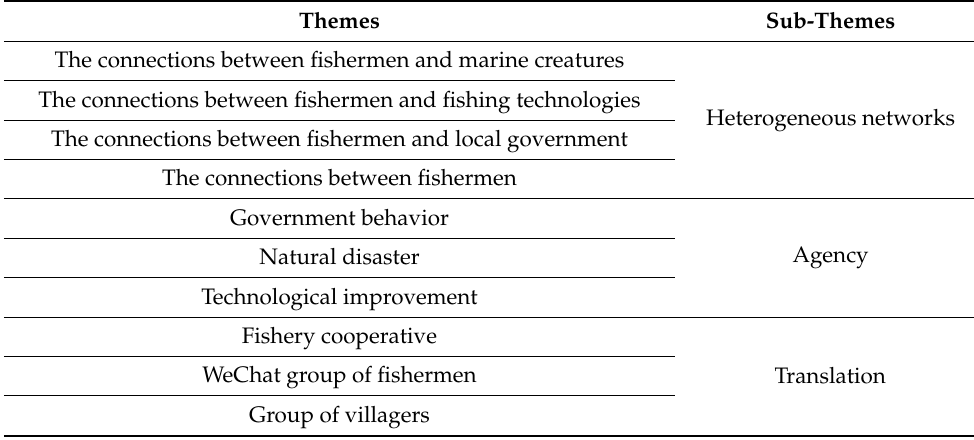
Table 4. Presentation of themes and